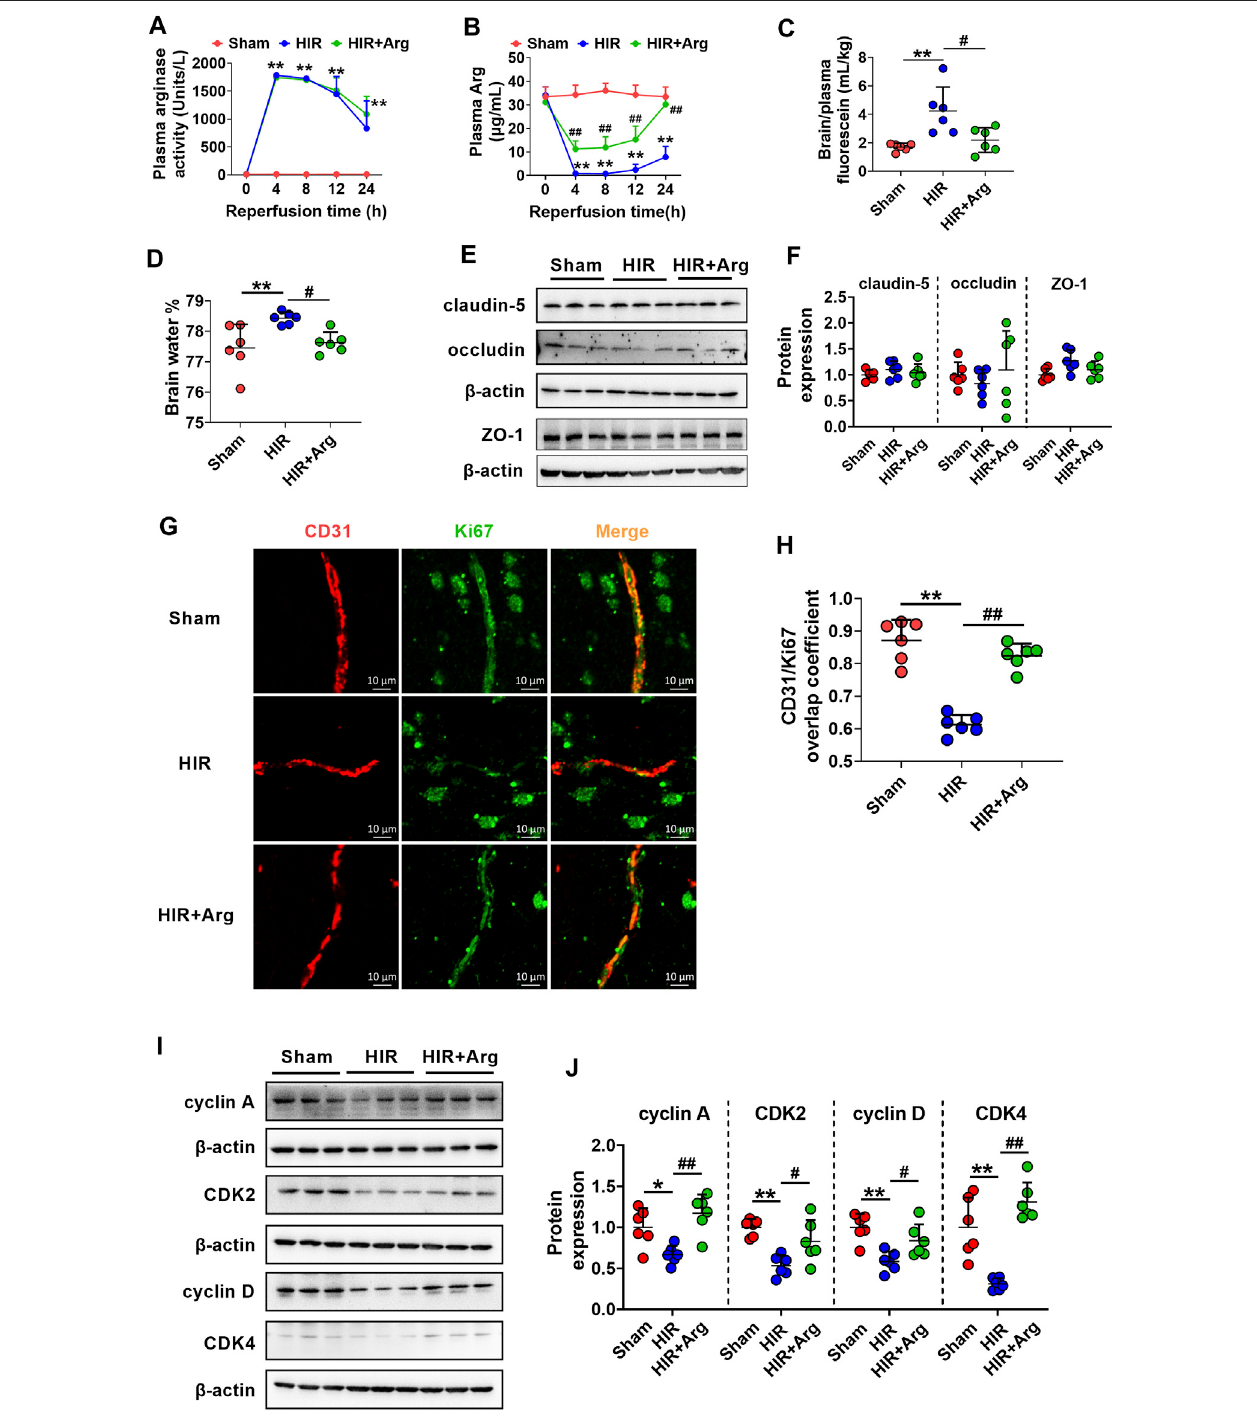
FIGURE 6 | HIR impaired BBB of rats via substantially increasing arginase release from the injured liver. (A) Plasma arginase activity and (B) arginine (Arg) level in sham-operated(Sham)rats,hepaticischemia-reperfusion (HIR)rats,andHIRratssupplementedwithArg(0.18 g/kg)beforesurgeryandat2,6,and12 hofreperfusion (HIR + Arg) ( n (cid:2) 6). (C) BBB permeability indexed as the ratio of brain to plasma fl uorescein and (D) brain water content in experimental rats ( n (cid:2) 6). (E,F) Western blot of tight junctions in the brain of experimental rats ( n (cid:2) 6). (G) Image of dual immuno fl uorescence of CD31 and Ki67 in the brain paraf fi n section and (H) the calculated overlap coef fi cient of CD31/Ki67 (to CD31) in experimental rats ( n (cid:2) 6). (I,J) Western blot cell cycle – related proteins in isolated cerebral microvessels from experimental rats( n (cid:2) 6).Datawereexpressedasmean ± SD.* p < 0.05,** p < 0.01versusShamrats; # p < 0.05, ## p < 0.01versusHIRrats;1-wayANOVAfollowedbyDunnett ’ s post hoc